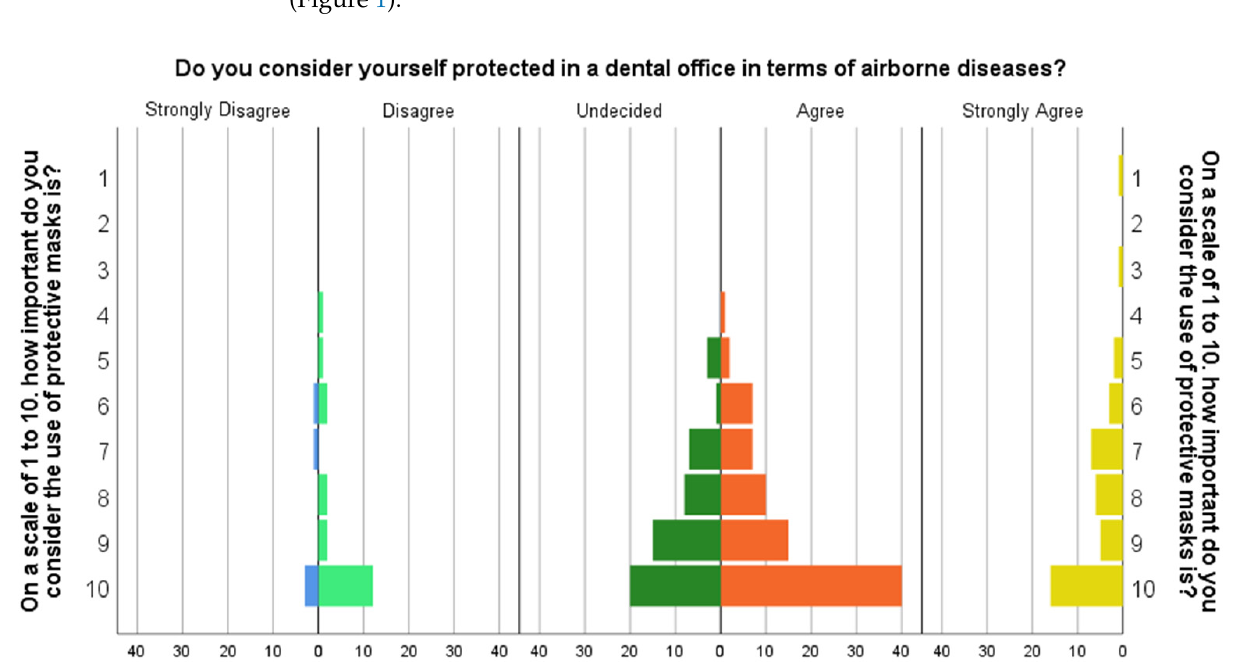
Figure 1. Subjects Pyramid Count “On a scale of 1 to 10. how important do you consider the use of protective masks is?” by “Do you consider yourself protected in a dental office in terms of airborne diseases?” The colors code is: Blue—Strongly Disagree; Light green—Disagree; Dark green—undecided; Orange—Agree, Yellow—Strongly Agree.